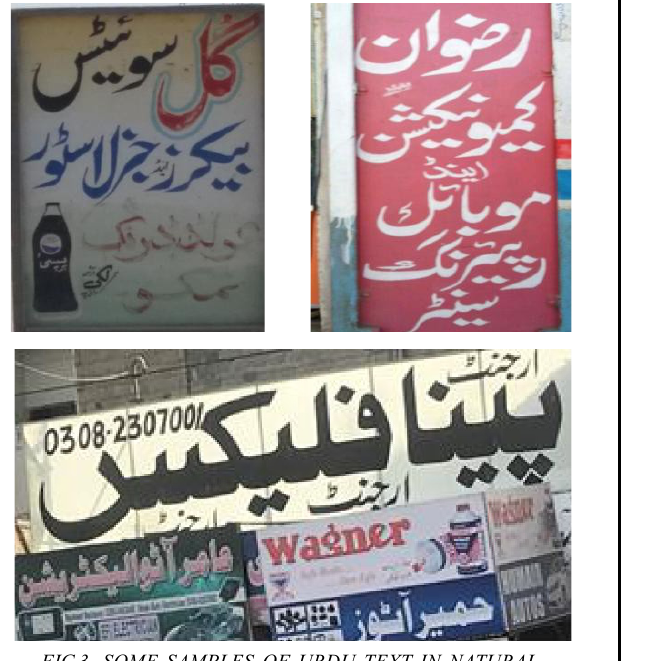
FIG.3. SOME SAMPLES OF URDU TEXT IN NATURAL SCENE IMAGES WHERE THE TEXT IS OVERLAPPING WHICH IS DIFFICULT TO SEGMENT